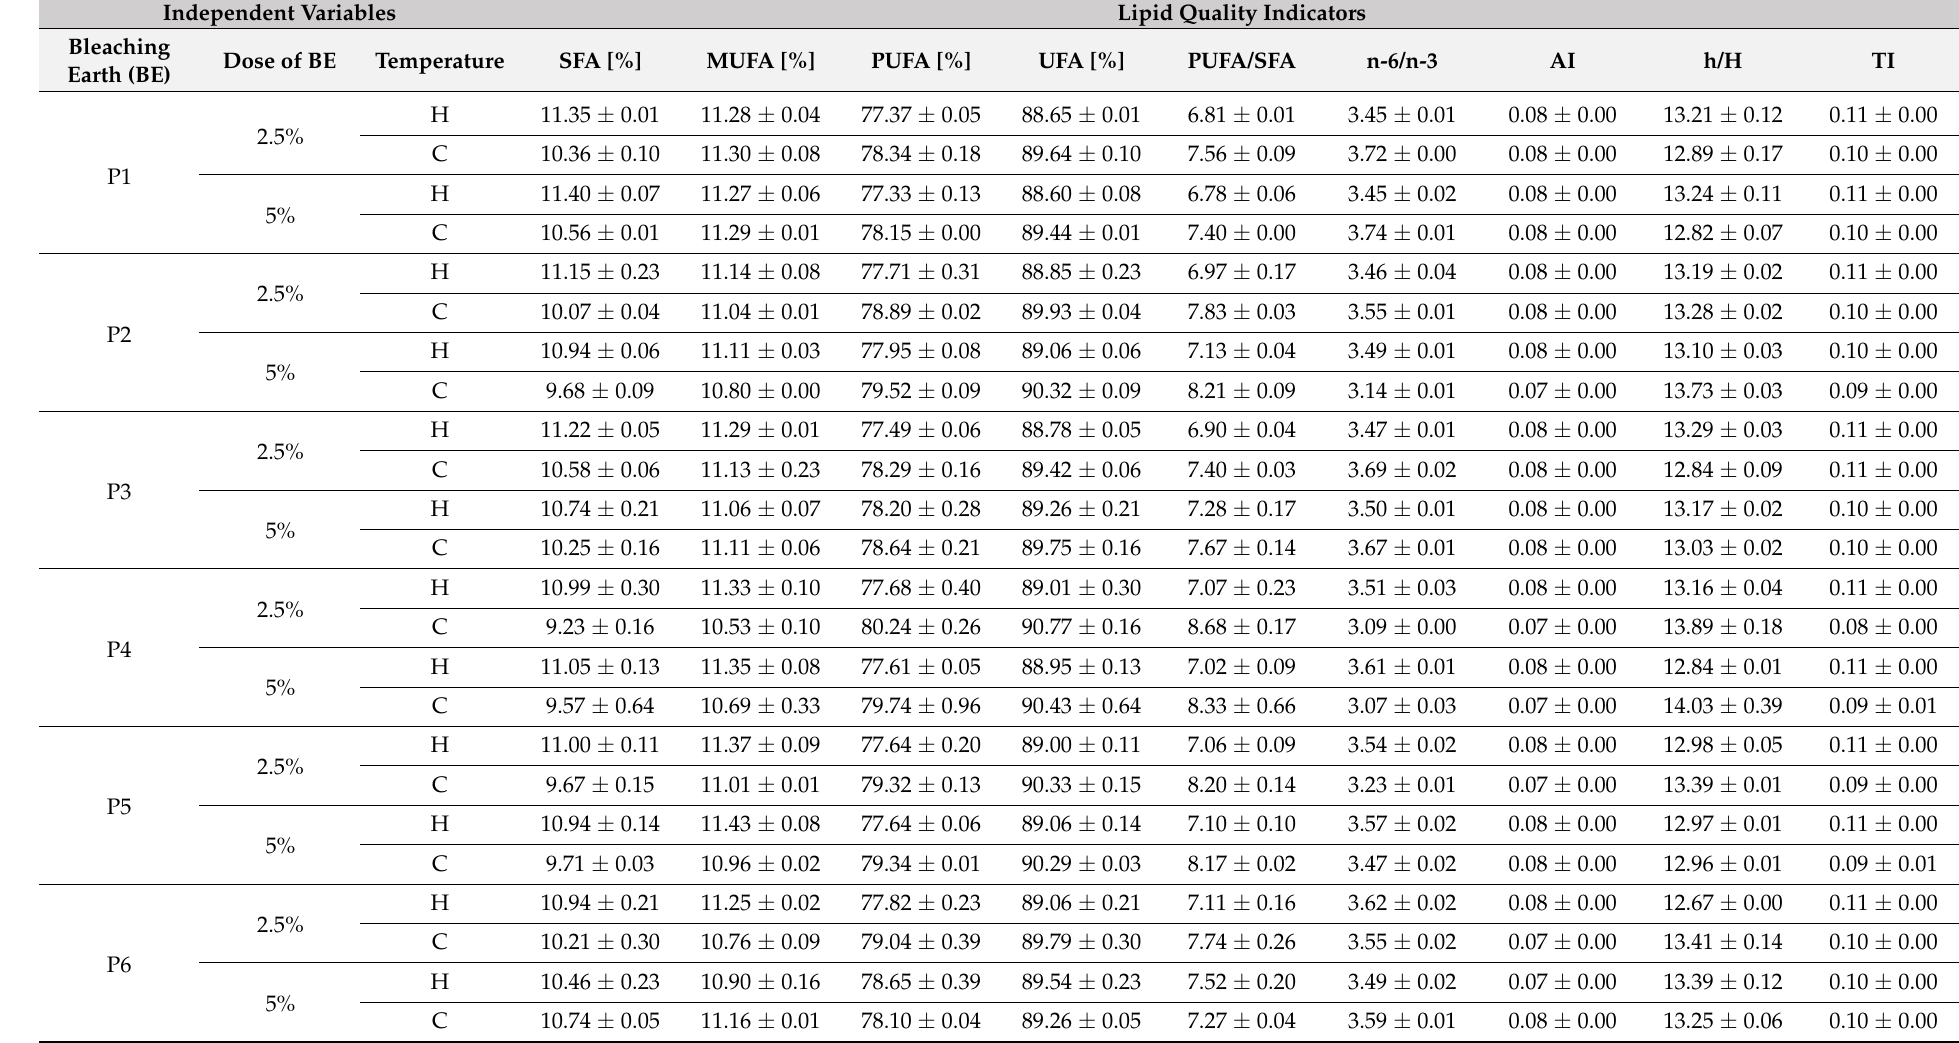
Table A4. Lipid quality indicators of bleaching hemp oil from the ‘Finola’